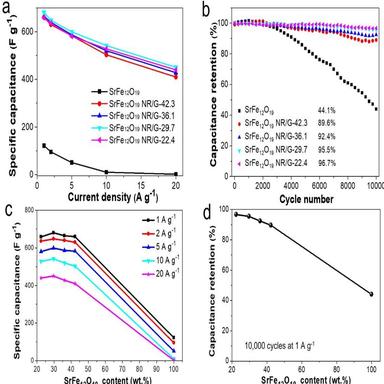
(a) Specific capacitances at different current densities and (b) cyclic properties of bare SrFe12O19 based device and different SrFe12O19 NR/G based devices; (c) Specific capacitances and (d) capacitance retention versus the SrFe12O19 content.